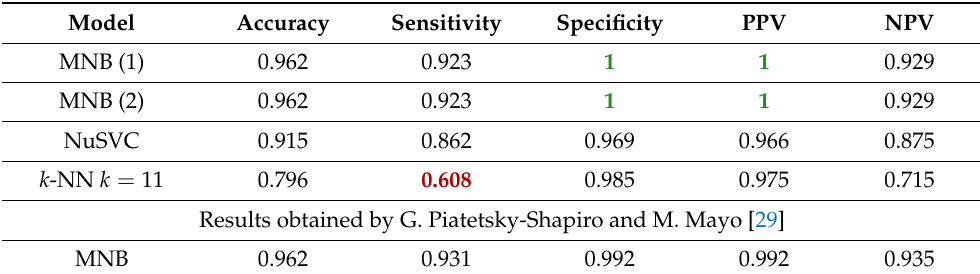
Table 17. Evaluation of the classifiers performance in Substage